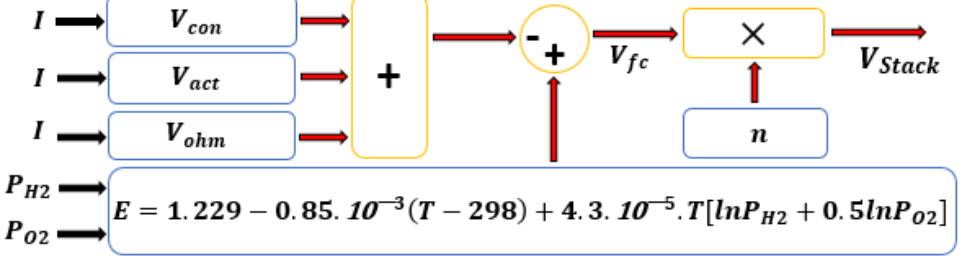
Figure 3. Fuel cell stack